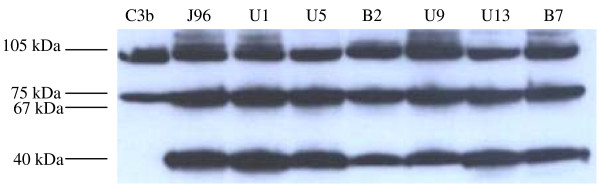
C3 deposition on E. coli isolates. 6 E. coli isolates (lane 3–8) were incubated with 5% NHS in culture medium for 30 minutes. C3 deposition was detected by Western blot analysis. Lane1, Purified C3b (0.1 μg); lane 2 J96 were incubated with 5% NHS; lanes 3–5 isolates showing positive for C3-dependent internalisation (U1, U5, B2); lanes 6–8, isolates not showing C3-dependent internalisation (U9, U13, B7). The presence of C3b is indicated by 105 kDa (α' chain) and 75 kDa (β chain) bands, iC3b by 75 kDa (β chain), 67 kDa (α1 chain), and 40 kDa (α2 chain) bands.